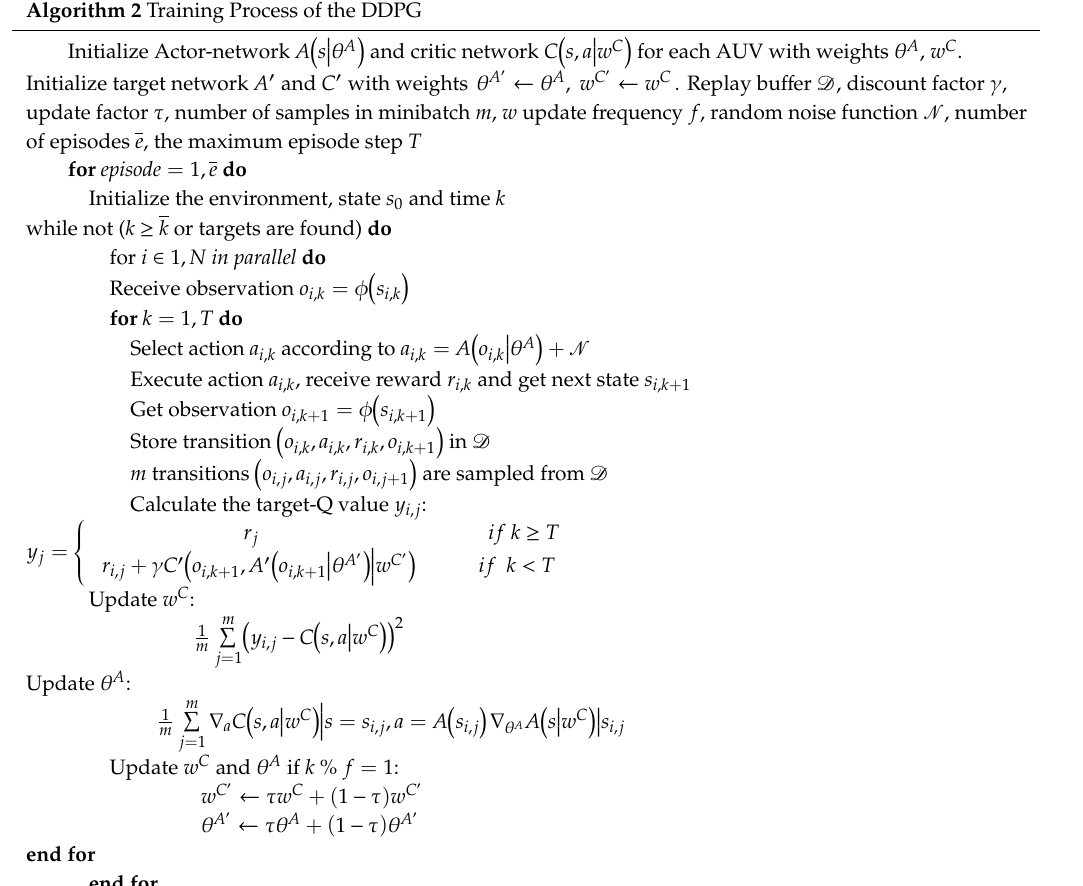
Algorithm 2 Training Process of the